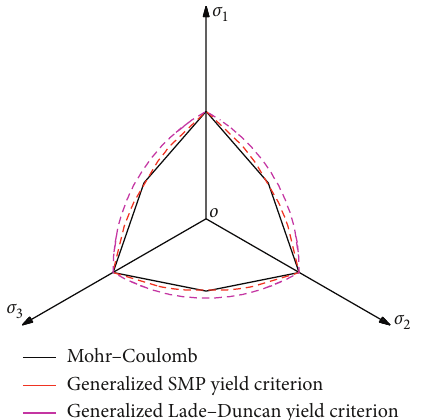
Figure 2: Comparison of MC, GLD, and GSMP criteria in the π -plane under plane strain